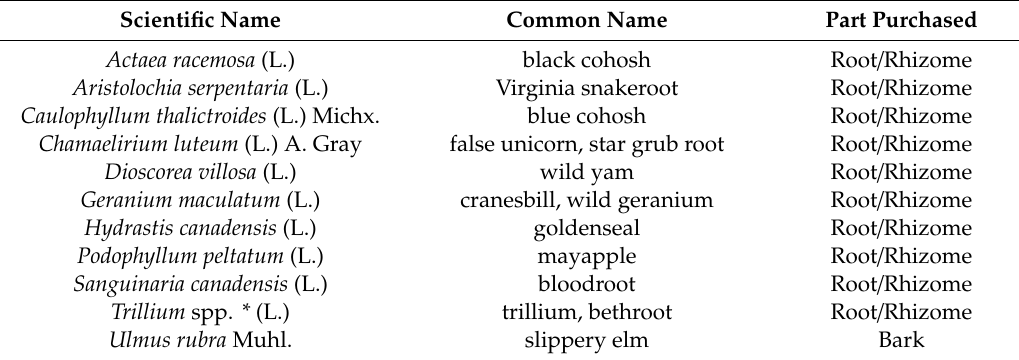
Table 1. Eleven ‘o ff -root’ (i.e., not American ginseng) eastern US, deciduous forest medicinal nontimber forest product (NTFP) species included in annual surveys of primary buyer purchasing in 2014 and 2015. The surveyed primary buyer population consisted of registered ginseng buyers in 15